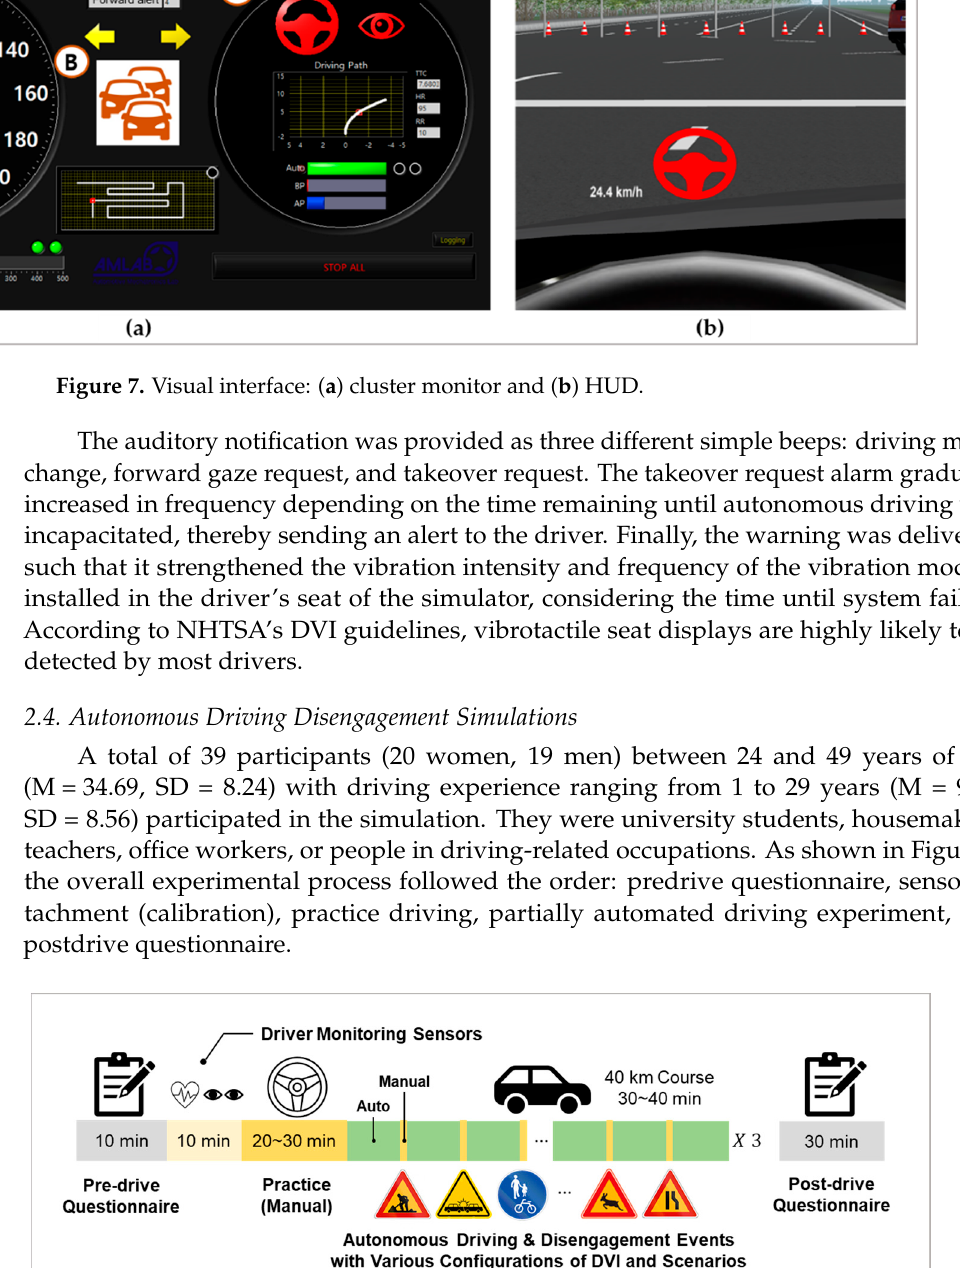
Figure 8. Schematic of the timeline of the experiments.